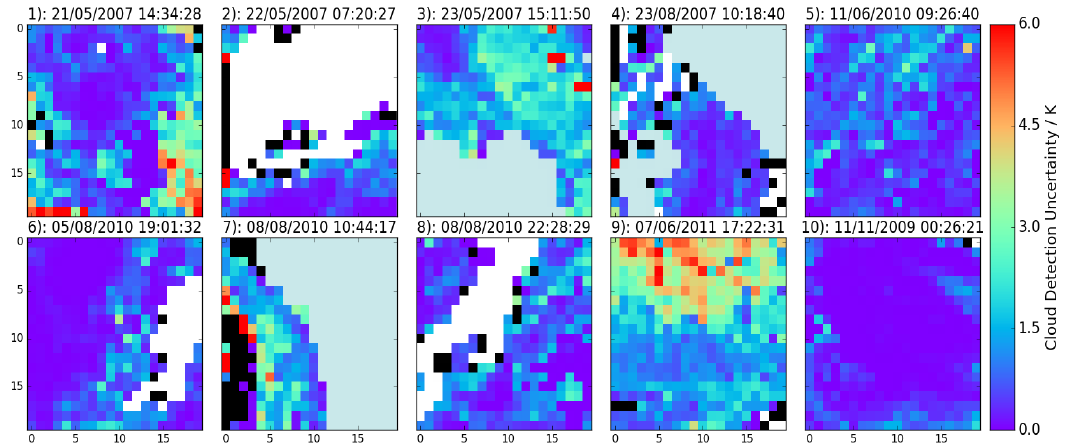
Figure 4. Cloud detection uncertainties for the 10 submission scenes in the cloud clearing inter-comparison (Tables 1 and 2) at 625-km 2 resolution. Individual plot headings give the scene number, date and orbit start time. White grid cells denote agreement between all masks on cloudy conditions. Black grid cells denote regions classified as entirely cloudy by the manual mask, but clear-sky in some of the contributing masks.